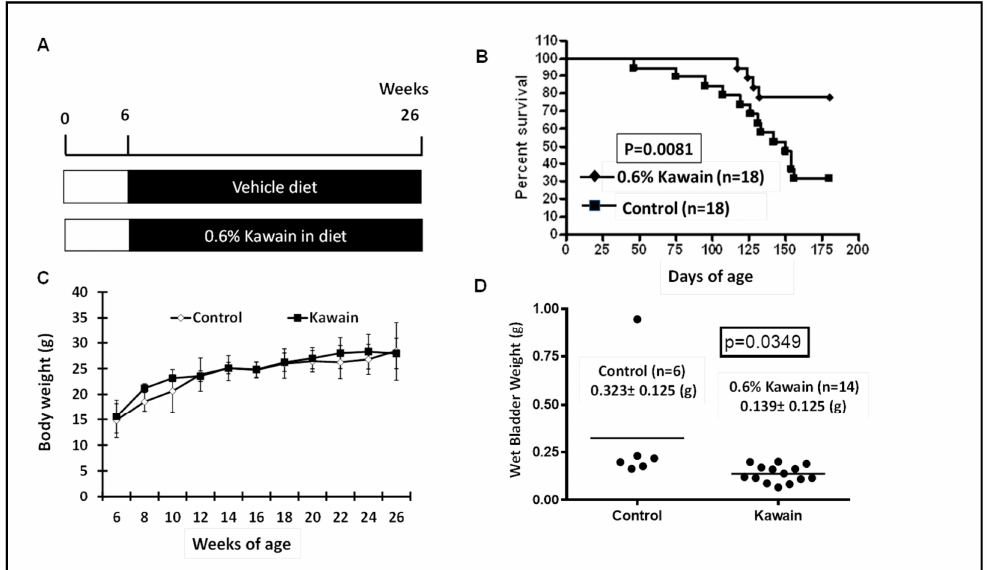
Figure 1. Dietary feeding of kawain reduces tumor burden and increases the survival of UPII-mu- tant Ha-ras mice. ( A ) An experimental protocol for evaluating chemopreventive efficacies of dietary kawain in the UPII-mutant Ha-ras model. ( B ) The survival curves of male mice fed with indicated diet beginning at 6 weeks of age until 6 months of age or up to their death. ( C , D ) The mean body weight documented every week and bladder weights at the end of the experiment of male UPII mutant Ha-ras mice fed with indicated diet as shown in the figure.